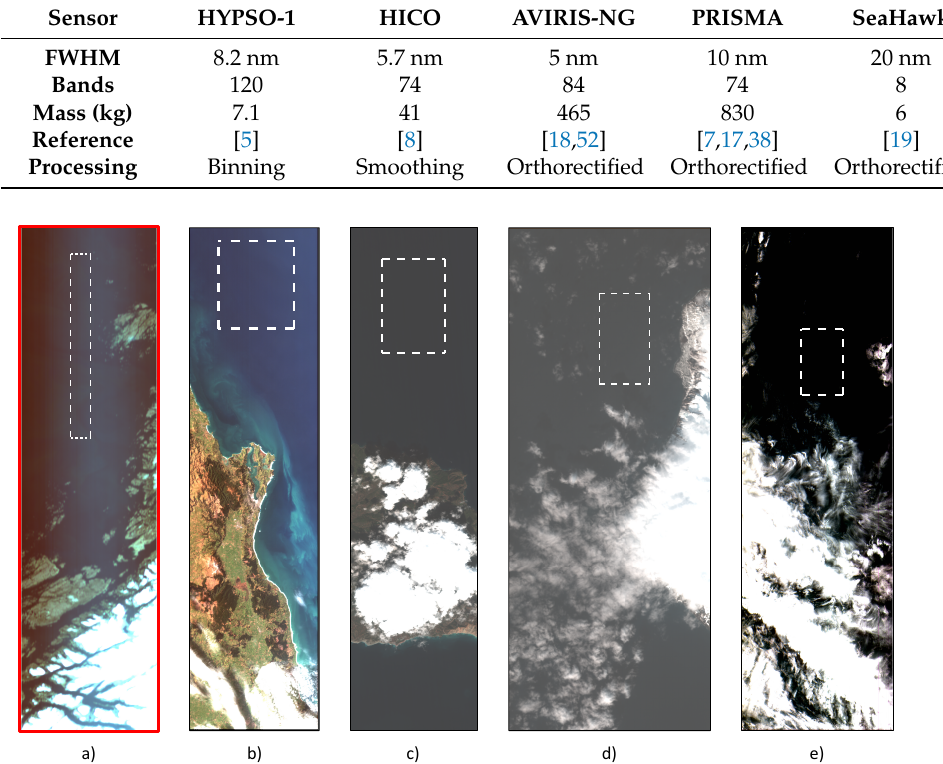
Table 8. Relevant sensor characteristics. The listed number of bands includes only those within the spectrum of the HYPSO-1 instrument. The mass refers to the weight of the platform, with an exception for the HICO as it was onboard the International Space Station (ISS).